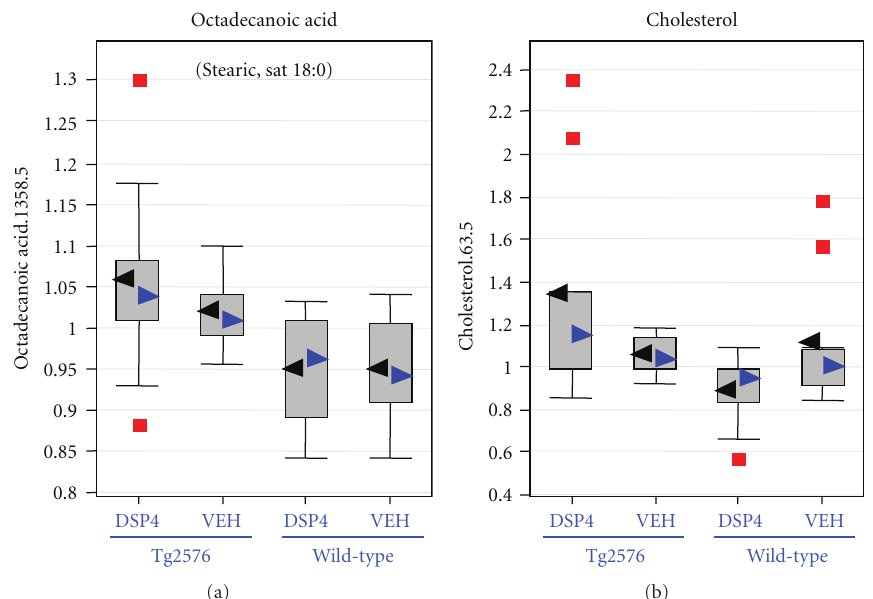
Figure 6: Lipids: Octadecanoic (stearic) acid and cholesterol. Box plots describing the modest elevations of octadecanoic acid and cholesterol in the brains of transgenic animals in which the locus coeruleus had been ablated. For each metabolite, the distribution of values within each of the four cohorts is represented as a Whisker plot, with the relative normalized intensity as the abscissa. Mean values represented by the black arrowheads, median values by blue arrowheads. Detailed statistical comparisons of both of these metabolites in the four cohorts are given in Table